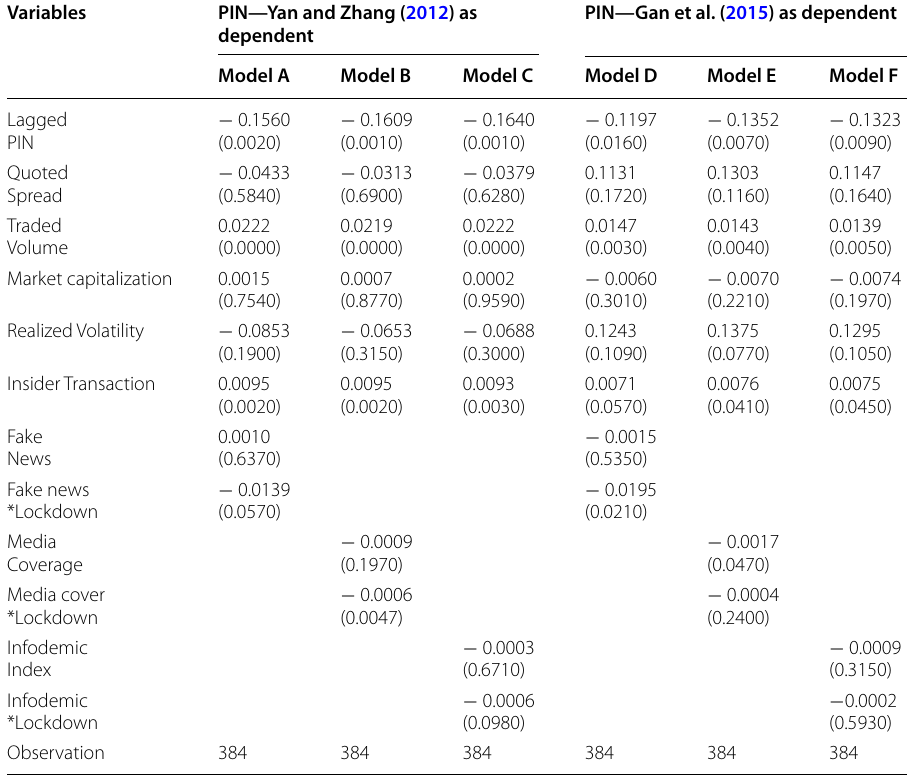
The p values are reported in